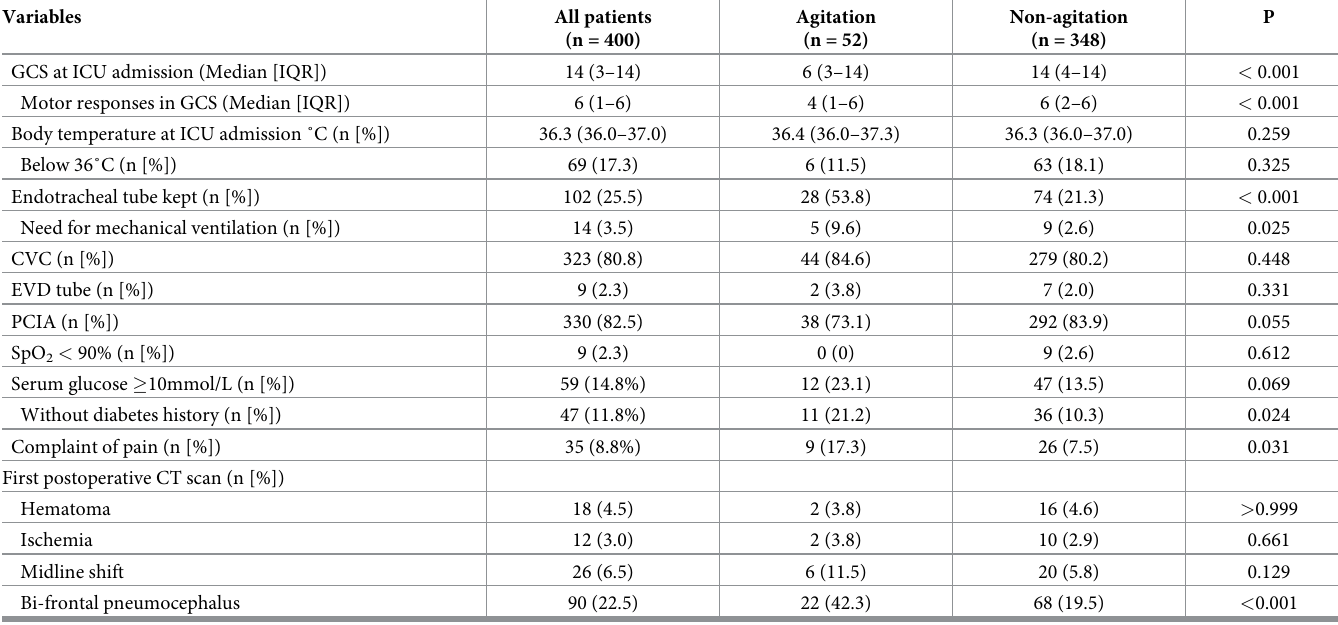
Table 3. Univariable analyses of ICU admission